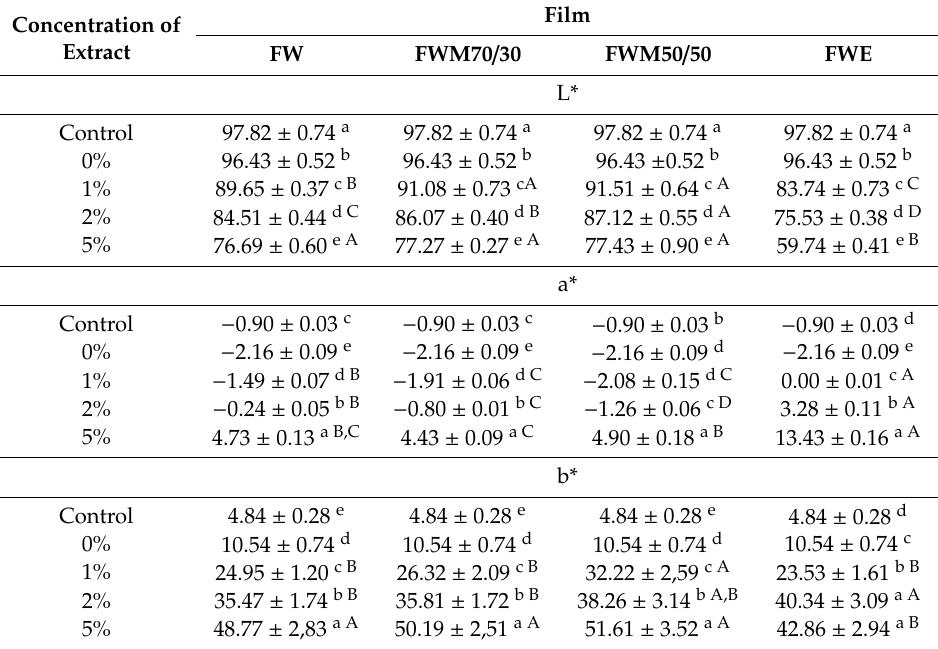
Table 8. Color of starch films with chicory root extracts and phytic acid in CIELAB color values. Concentration